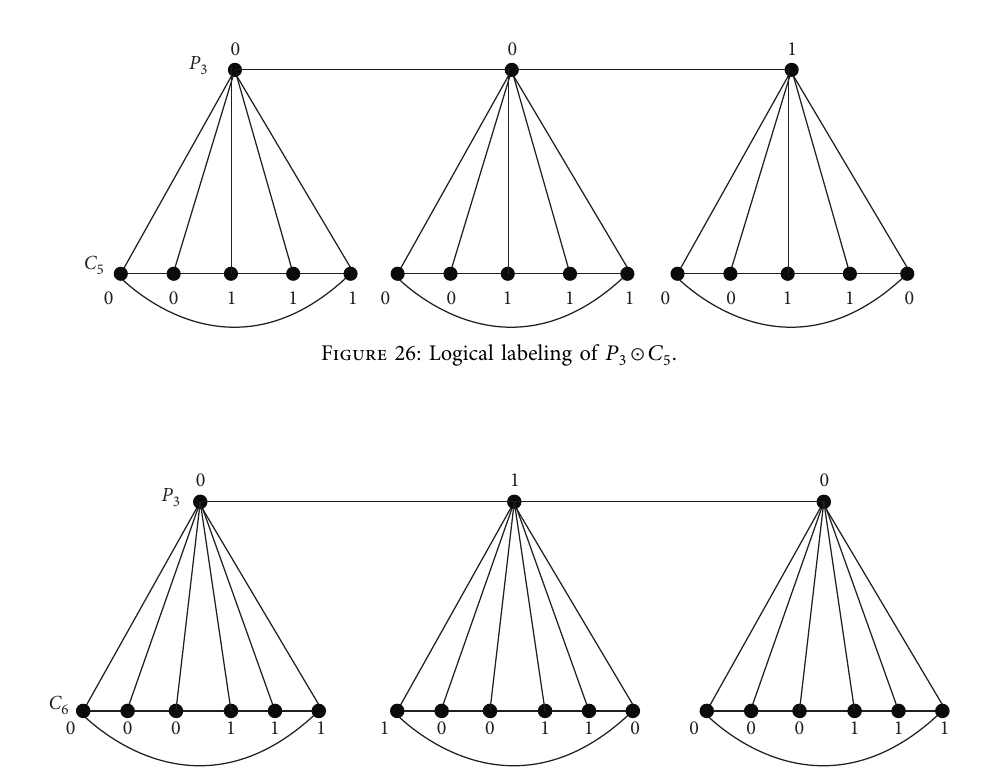
Figure 27: Logical labeling of P